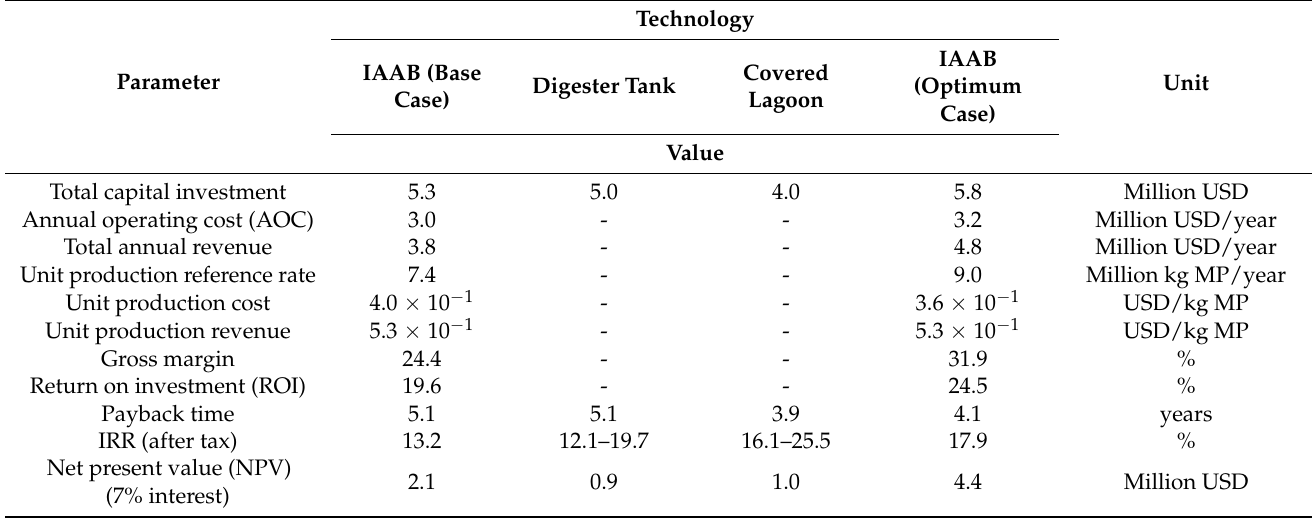
Table 4. Executive summary of POME treatment using IAAB (Current study). Note: MP (Main Product) = Total flow of stream “Treated Biogas” (Based on 60 tons/h palm oil